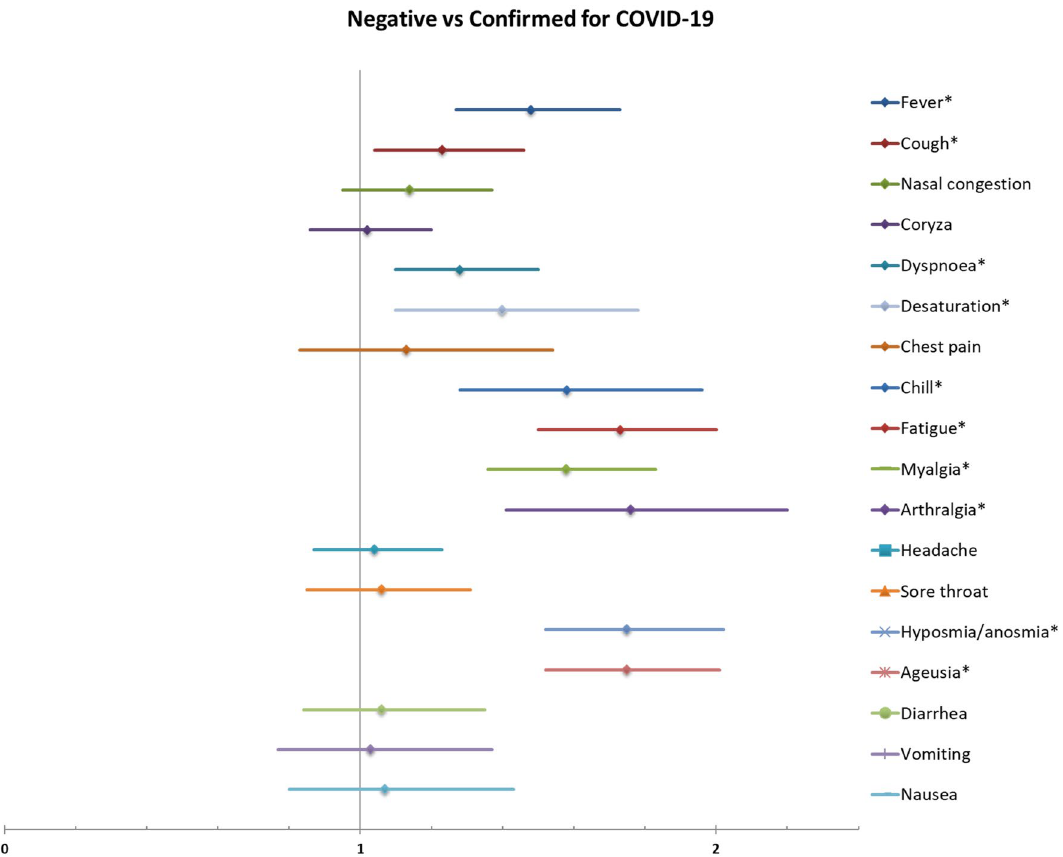
Figure 4. Risk ratios for confirmed COVID-19 in symptomatic women according to symptoms at